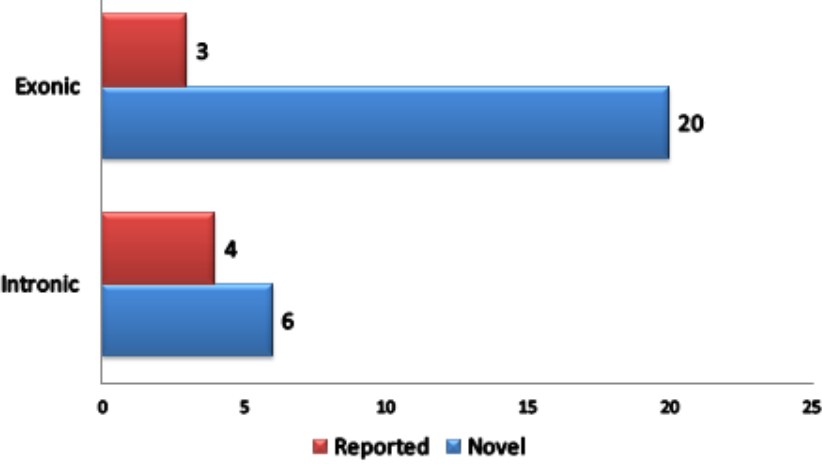
Figure 3. Statistical distribution of variants identified after filtering strategy.